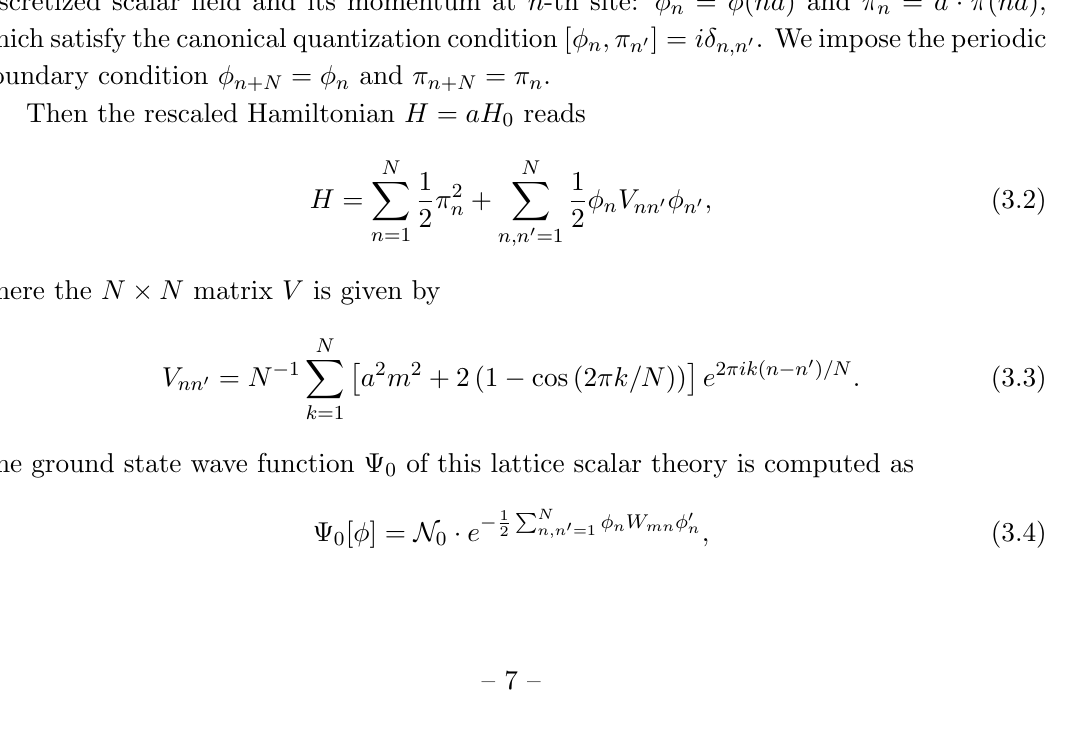
Figure 4 . The holographic mutual information I ( A : ~ A ) subtracted by 2 S A . We set c size l = 1. It monotonically increases if we do not care about the phase transition at d (cid:3) =